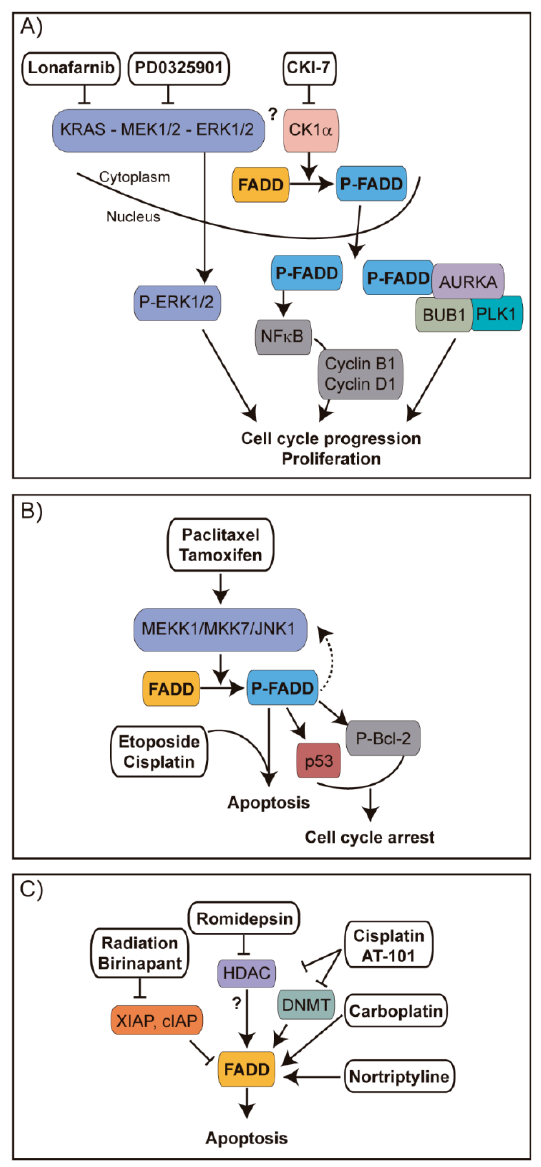
Figure 10. Strategies for therapeutic intervention of cancer involving FADD. ( A ) In lung cancer, CKI α -mediated phosphorylation of FADD leads to the translocation of S194-P-FADD to the nucleus, where it can induce expression of cyclins B1 and D1 through NF- κ B signaling [5], or it can interact with key G2/M transition proteins like AURKA, PLK1 or BUB1 [102], promoting cell cycle progression and proliferation. Inhibiting KRAS with Lonafarnib, MEK with PD0325901, or CK1 α with CKI-7 decreased the abundance of phosphorylated FADD and decreased cell proliferation, apparently due to a loss of interaction between FADD and the G2/M transition proteins. As a result, tumor treated cells would fail to progress through G2/M. ( B ) Tamoxifen and paclitaxel in breast cancer [155] and paclitaxel in prostate cancer [165] have been reported to activate the MEKK1/MKK7/JNK pathway, which contributes to FADD phosphorylation. In breast cancer, this results in cell cycle arrest and suppression of cancer growth through p53 stabilization or Bcl-2 phosphorylation. In prostate cancer, phosphorylated FADD in turn upregulates MEKK1 and downstream JNK1 activation, which is essential for sensitization to apoptosis induced by etoposide or cisplatin combined with paclitaxel [165]. Thus, chemosensitization can be amplified through FADD phosphorylation and the MEKK1/MKK7/JNK1 pathway. ( C ) In head and neck cancer, the SMAC mimetic Birinapant plus radiation induces tumor regression [16]. Radiation induces DNA damage and in consequence the intrinsic cell death pathway through mitochondrial release of SMAC. The negative effect of SMAC on IAPs is enhanced by SMAC mimetic Birinapant, resulting in degradation of IAPs to enhance FADD-